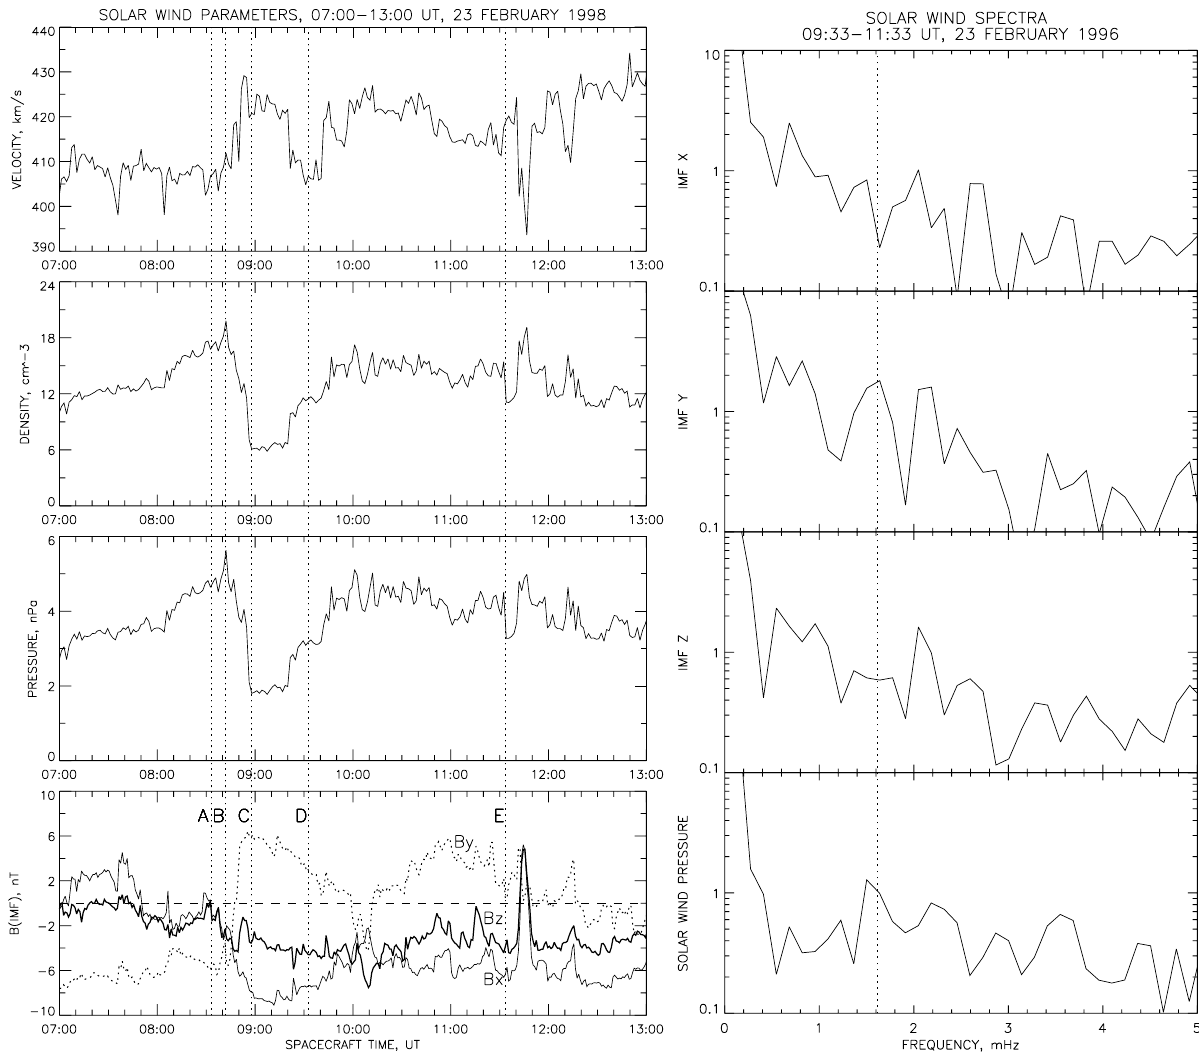
Fig. 2. (a, left) WIND solar wind plasma and magnetic field data, 07:00–13:00UT, 23 February 1996. Top three panels show the solar wind speed, then ion density, dynamic pressure, and magnetic field, all in GSM coordinates. For the bottom panel the thin solid line represents the B x component, the dotted line the B y component, and the thick solid line the B z component. Vertical dotted lines denote times when B z turns negative (labelled “A”), when solar wind pressure begins to drop (“B”) and reaches minimum (“C”), and the interval of oscillations considered in detail (“D” to